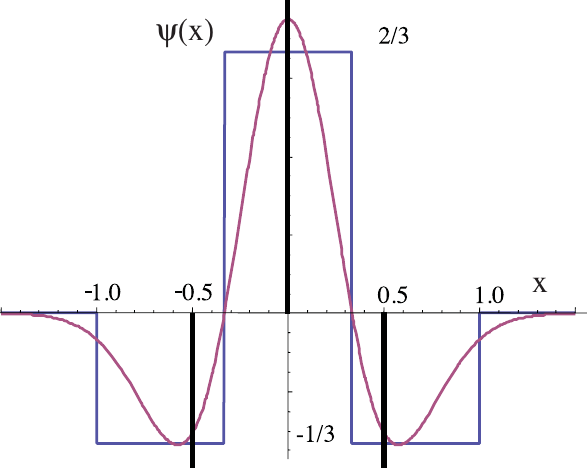
Fig. 4. The popular Mexican hat wavelet (the second derivative of the Gaussian red, valid for − 1 < H < 2) compared with the (nega- tive) of the second finite difference wavelet (black bars representing the relative weights of δ functions, valid for 0 < H < 2), and the second-order “quadratic” Haar wavelet (blue) Eq.